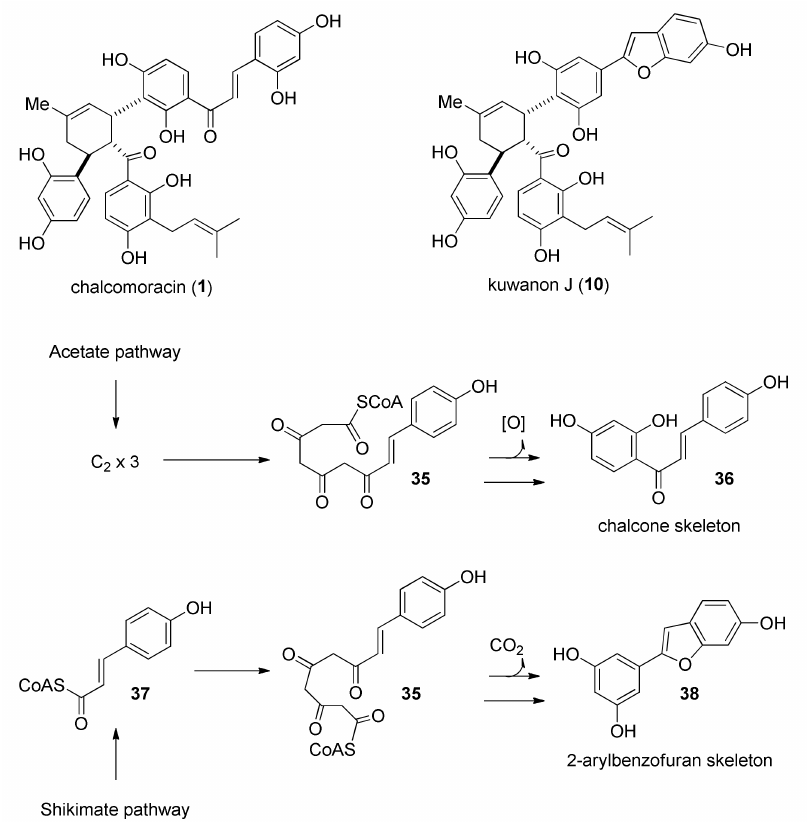
Figure 10. Biogenesis of chalcone 36 and 2-arylbenzofuran 38 in M. alba cell cultures producing kuwanon J ( 10 ) and chalcomoracin ( 1